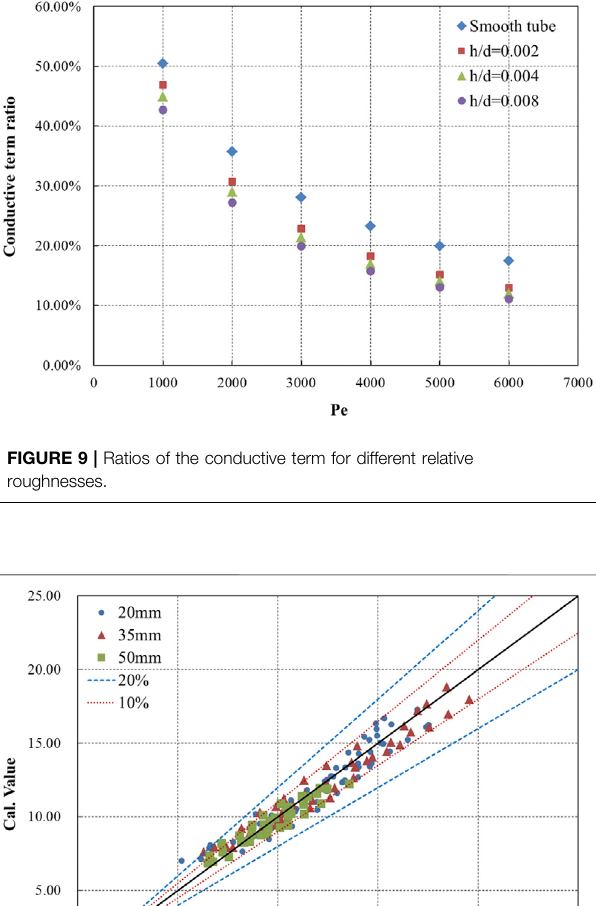
TABLE 3 | Coef fi cients of Eq. 30 for different relative roughnesses.